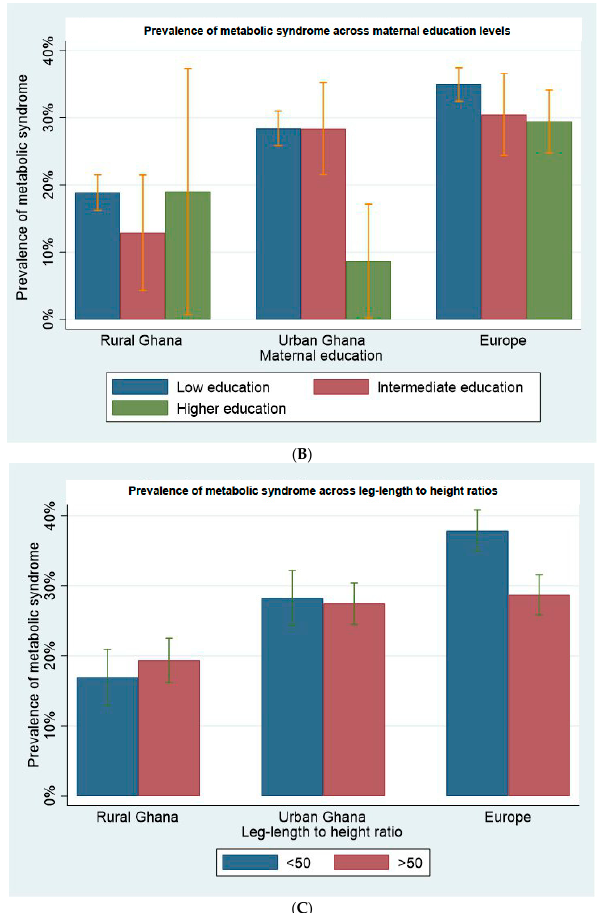
Figure 1. ( A ) Prevalence of metabolic syndrome across paternal education levels in rural Ghana, urban Ghana and among Ghanaian migrants in Europe. Error bars are the 95% confidence intervals. ( B ) Prevalence of metabolic syndrome across maternal education levels in rural Ghana, urban Ghana and among Ghanaian migrants in Europe. Error bars are the 95% confidence intervals. ( C ) Prevalence of metabolic syndrome across maternal education levels in rural Ghana, urban Ghana and among Ghanaian migrants in Europe. Error bars are the 95% confidence intervals.